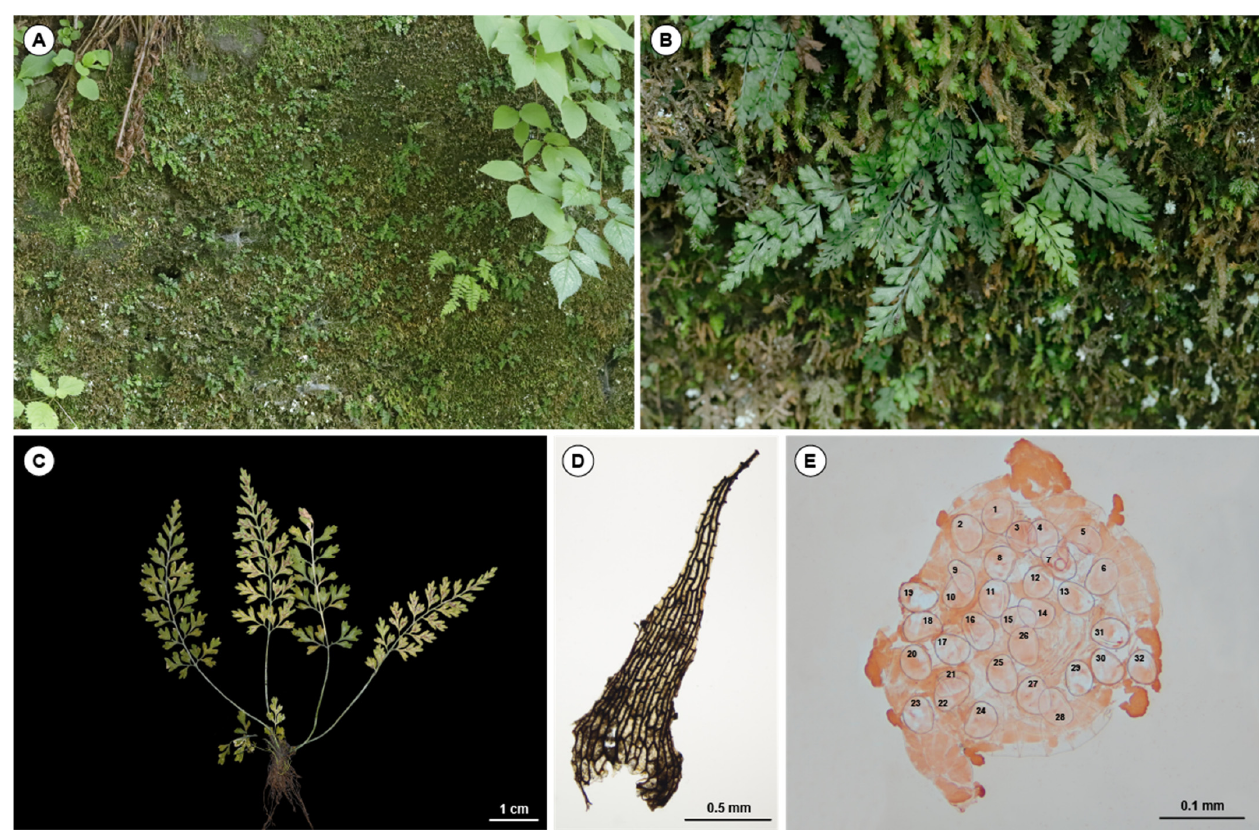
Figure 4. Asplenium pseudocapillipes sp. nov. ( A , B ) Habitat. ( C ) Plant. ( D ) Rhizome scale. ( E ) Thirty-two spores per sporangium.